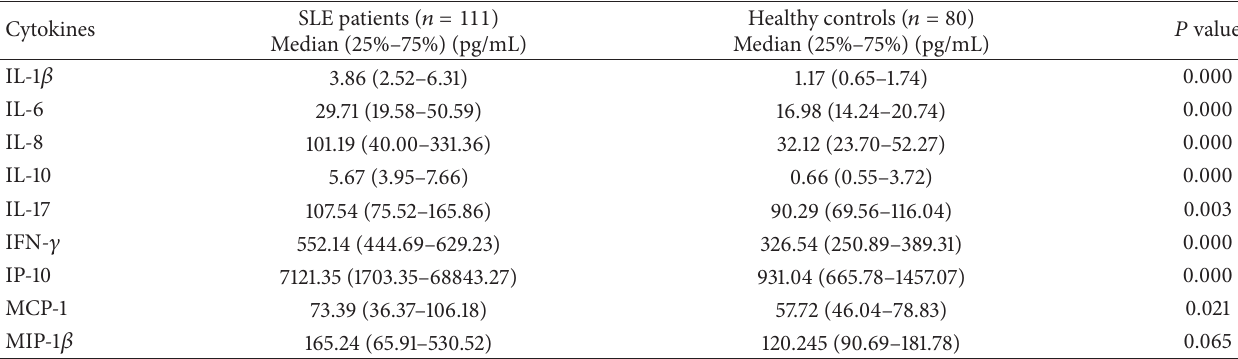
Table 3: Serum cytokine levels of SLE patients and healthy controls.